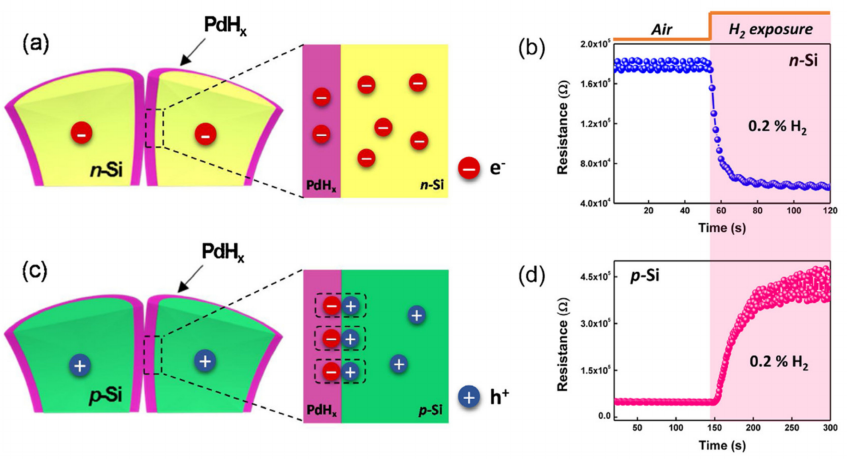
Figure 11. Schematic illustration of H 2 sensing mechanisms in ( a ) n- and ( c ) p-type Pd-coated SiNW arrays based on carrier concentration. Resistance variation with time for 0.2% H 2 depending on the major carrier types in ( b ) n- and ( d ) p-type Pd-coated Si NW arrays. Reproduced from [139], with permission from Elsevier, 2020.